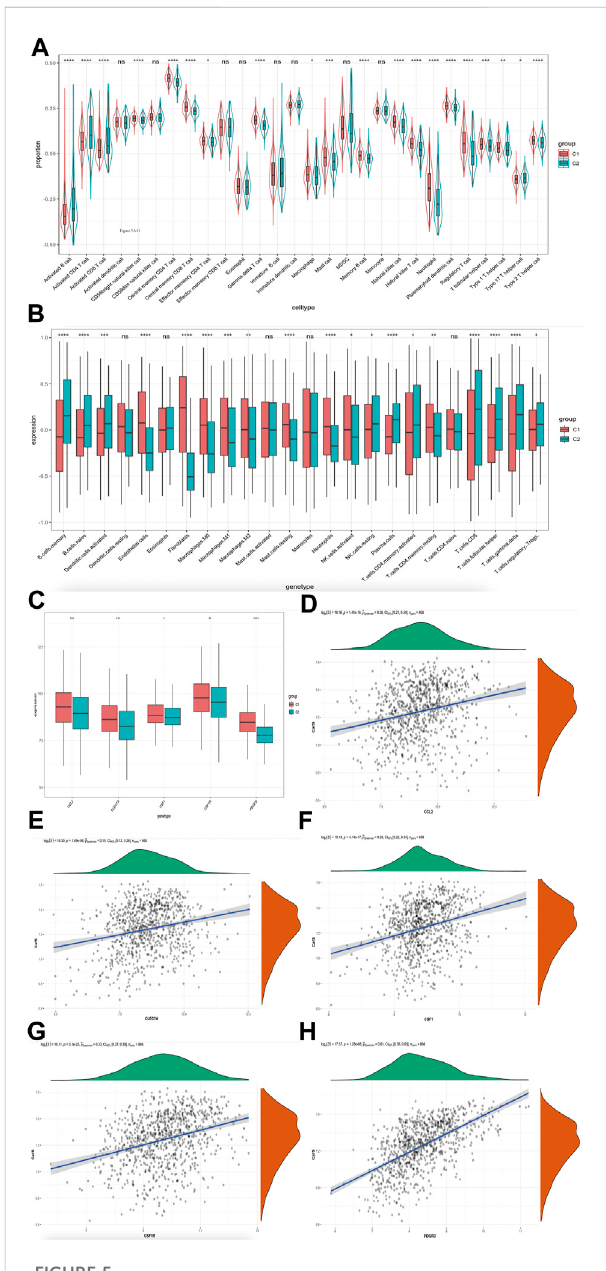
FIGURE 5 CafS changes the tumor immune microenvironment and is related to tumor associated macrophage (TAM) (A) Enrichment of 28 immune cell types in fi ltrating in the groups of CafS; combined database; the asterisk represents the different p values (* < 0.05; ** < 0.01; *** < 0.001, **** < 0.0001). (B) Boxplot of 24 immune cell types in fi ltrating by CIBERSORT algorithm in the groups of CafS; combined database; the asterisk represents the different p values (* < 0.05; ** < 0.01; *** < 0.001, **** < 0.0001). (C) Five genes ’ expression of tumor associated macrophage (TAM) in the groups of CafS; the asterisk represents the different p values (* < 0.05; ** < 0.01; *** < 0.001,**** < 0.0001). (D – H) CorrelationbetweenCafSandCCL2, CLEC7A, CSF1,CSF1RandPDGFB(CafS andCCL2:r=0.28, p =1.44e- 16; CafS and CLEC7A: r = 0.19, p = 1.69e-08; CafS and CSF1: r = 0.28, p = 4.14e-17; CafS and CSF1R: r = 0.33, p = 3.1e-23; CafS and PDGFB: r = 0.61, p =